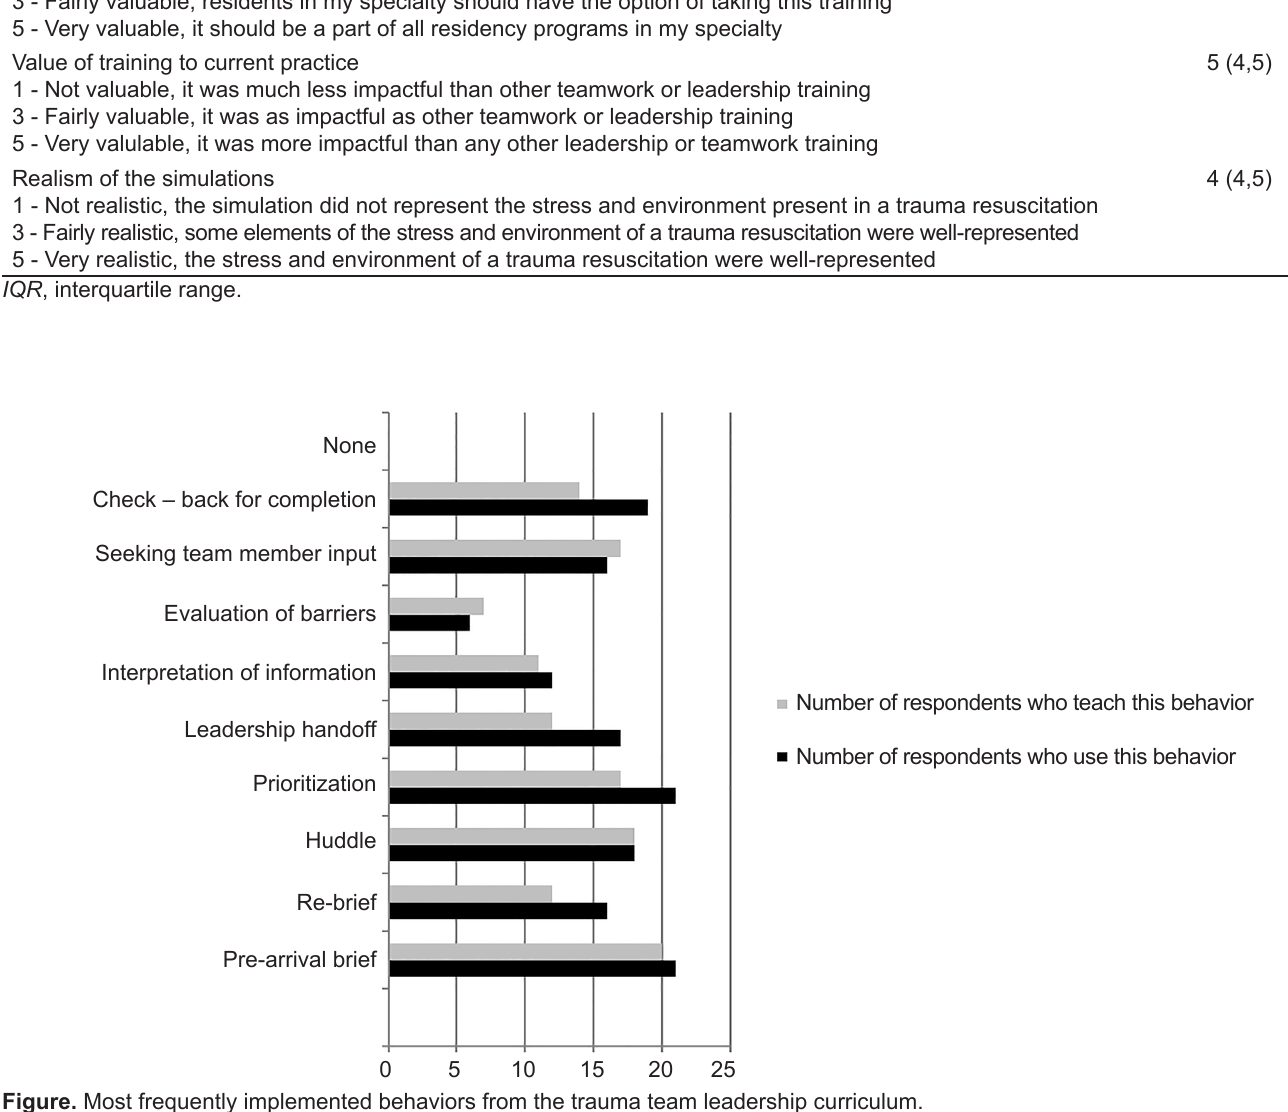
Figure. Most frequently implemented behaviors from the trauma team leadership curriculum.